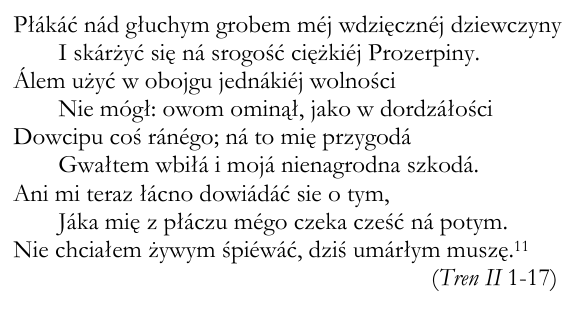
Massilia: Tumulus Massilae vernulae I,